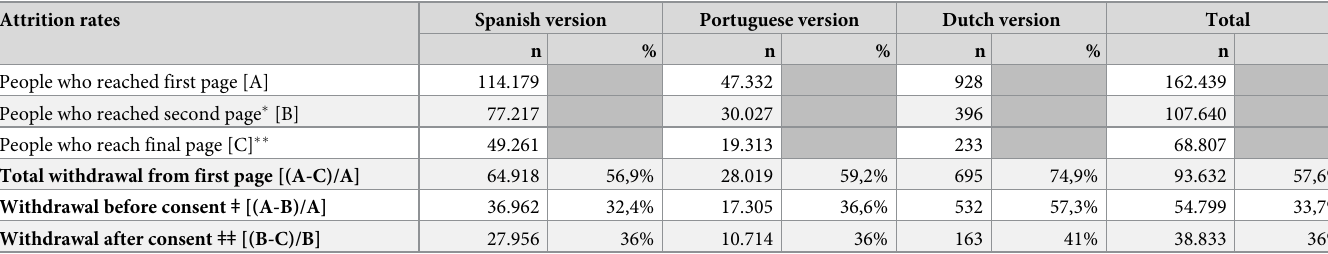
Table 1. Attrition rates throughout LAMIS-2018 questionnaire by language